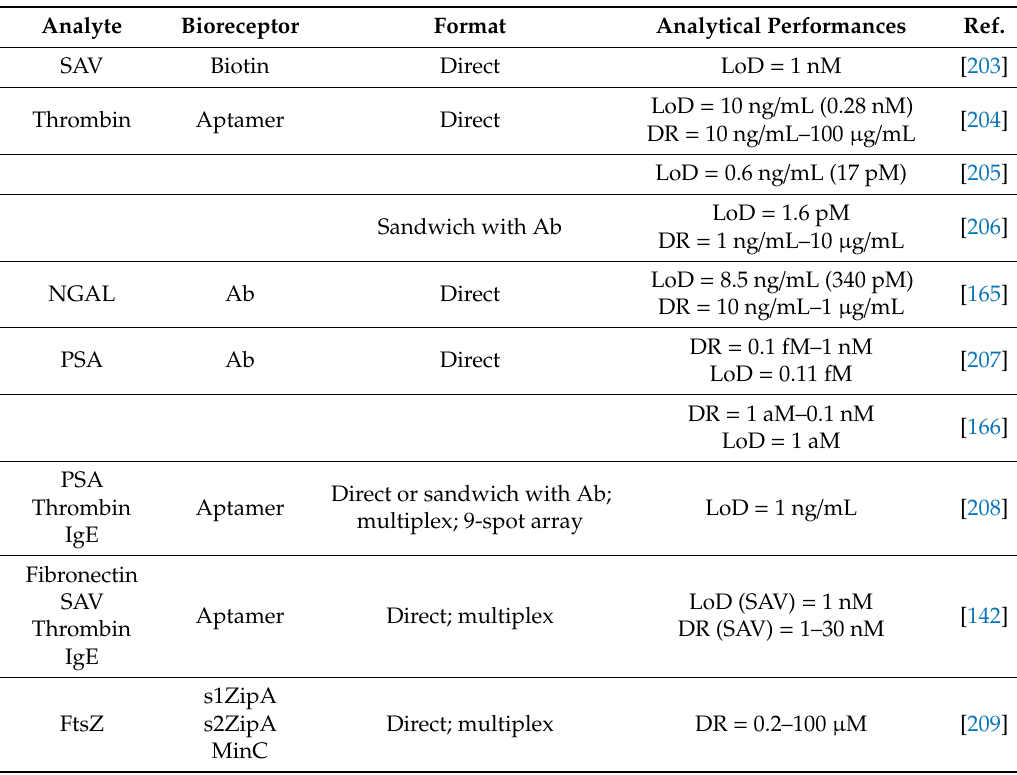
Table 8. Strategies, analytes, bioreceptors, and analytical performances for single molecule plasmonic